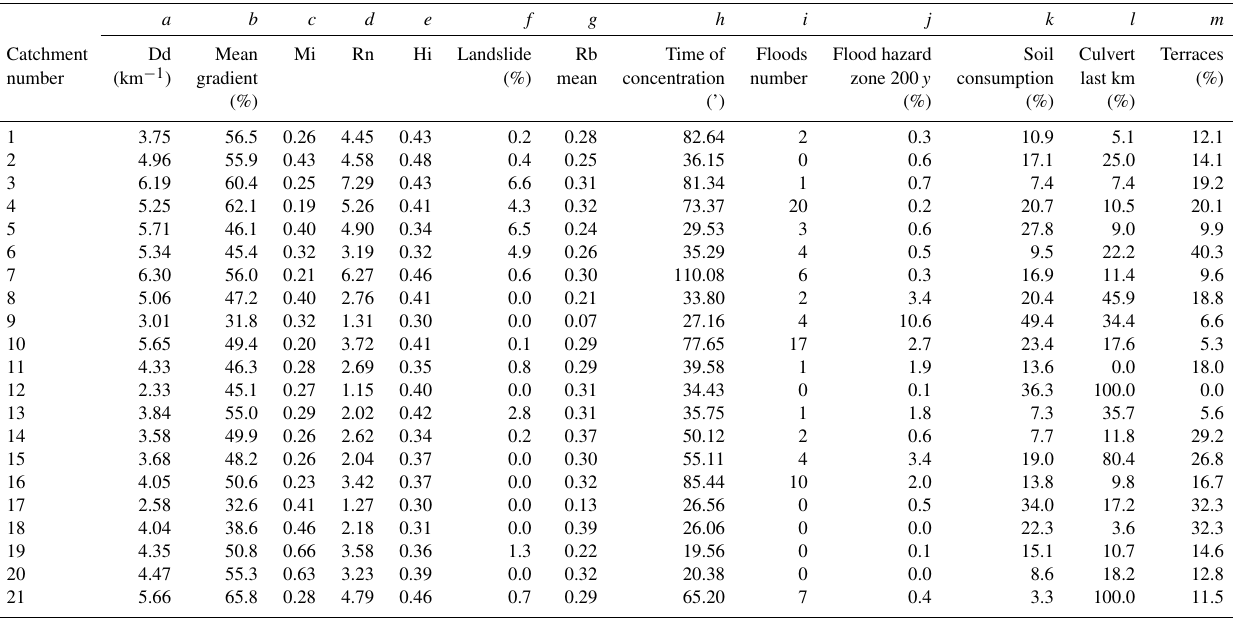
Table 4. The geodatabase with the chosen criteria related to geo-hydrological hazard. The a through j parameters are related to natural features, while the k through m parameters are related to anthropogenic modifications.